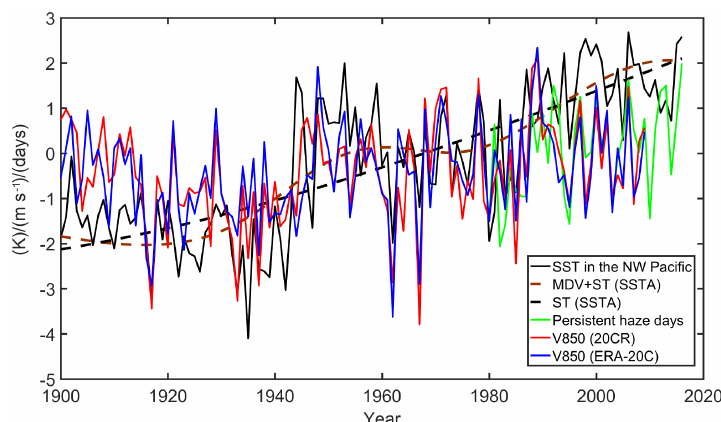
Figure 6. Time series of the normalized SSTA in the northwestern (NW) Pacific (black), meridional wind anomaly at 850hPa in North China from the 20CR (red) and ERA-20C (blue) datasets and persistent haze days (green) from 1900 to 2016. The climatic mean is calculated for the period 1961–1990. The black dotted curve is the secular trend (ST) of the SSTA series; the brown dotted curve is the combination of the secular trend and the multidecadal variability (MDV) of the SSTA series, obtained via the EEMD